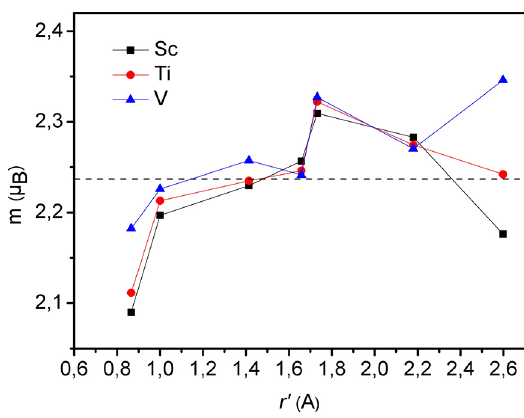
Figure 5. Calculated local magnetic moment ( m ) at non-equivalent irons sites for α-Fe(TM) (TM = Sc, Ti, and V) expressed as function of r’ . The dashed horizontal line correspond to m of pure α-Fe.